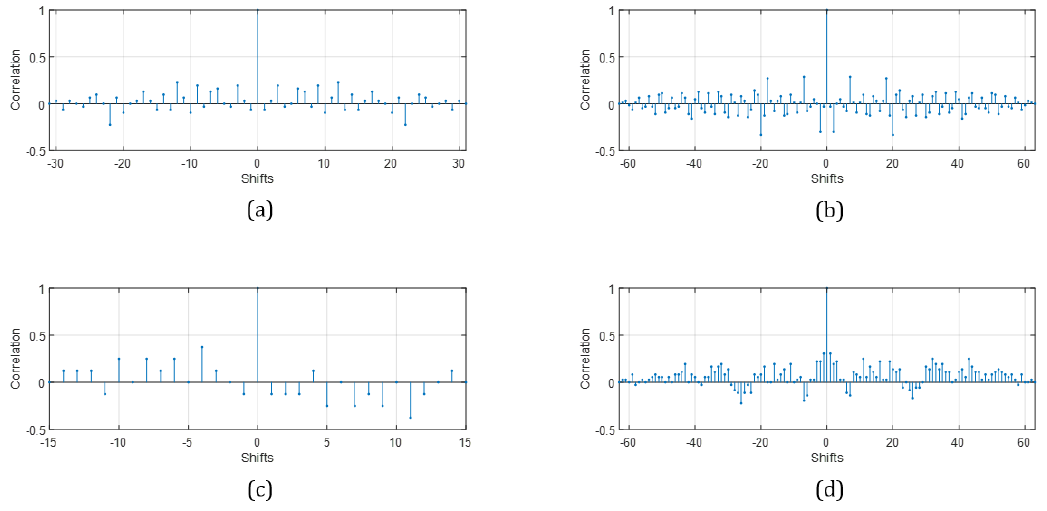
Figure 1. Autocorrelation of orthogonal codes. ( a ) 31-bit Gold code; ( b ) 63-bit Gold code; ( c ) 15-bit Kasami code; ( d ) 63-bit Kasami